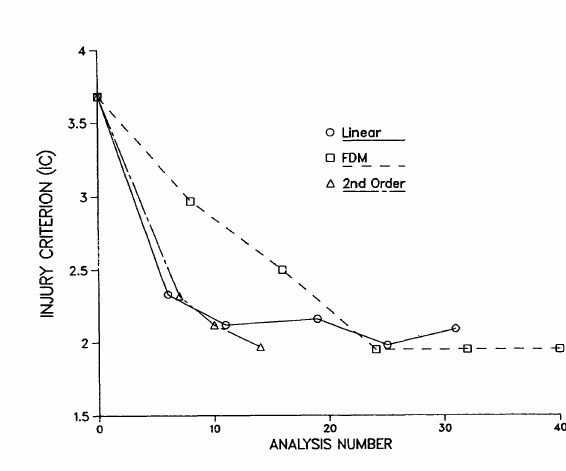
FIGURE 6 Optimization histories for example